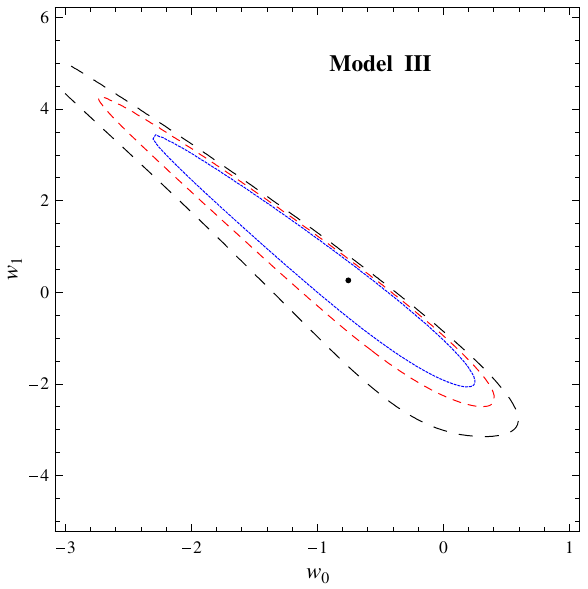
Fig. 17 Variations of w 0 and w 1 in the joint analysis (SNIa+BAO+CMB+Hubble) for the JBP parameterization (Model III). We plot the graphs for different confidence levels 66% (solid, blue), 90% (dashed, red) and 99% (dashed, black) contours for ( w 0 , w 1 ) by fixing the other parameters β = − 0 . 5 , D = 5 ,w m = − 0 . 3 ,ω =